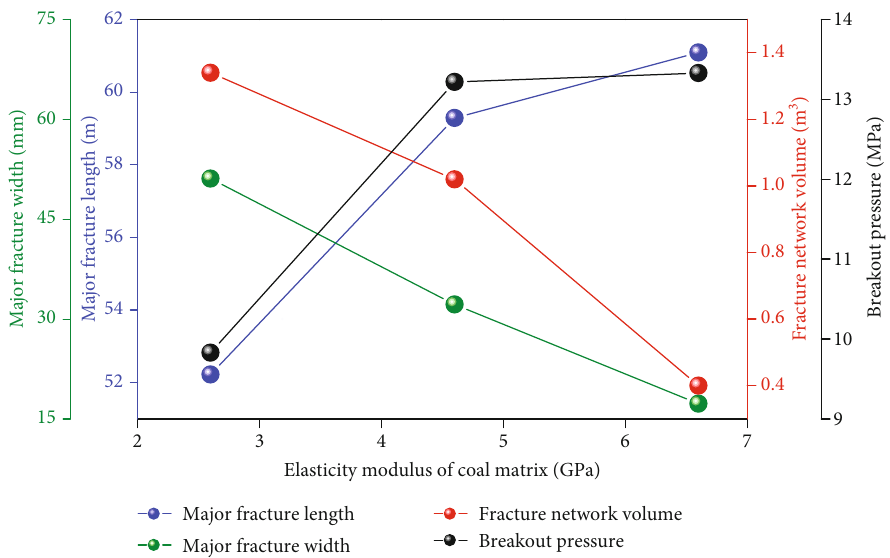
Figure 10: In fl uence of elastic modulus of coal matrix on hydraulic fracture